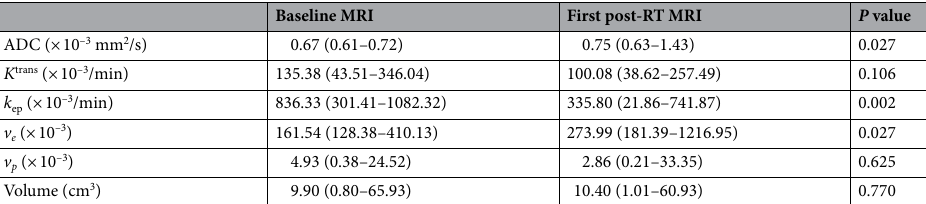
Table 3. MRI parameters before and after RT. Numbers are medians and ranges in parentheses. MRI, magnetic resonance imaging; ADC, apparent diffusion coefficient; K trans , volume transfer constant; k ep , rate constant; RT, radiation therapy; v e , volume fraction of the extravascular extracellular matrix; v p , blood plasma